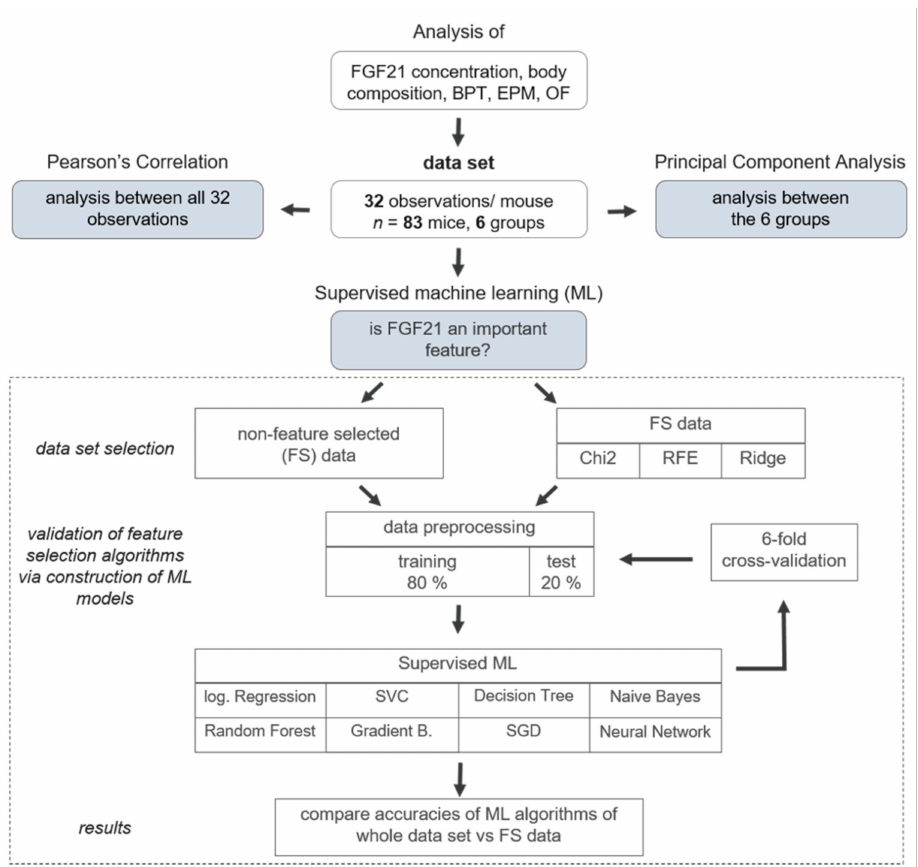
Table S1). To correlate all 32 observations, Pearson’s correlation was performed where linear relationship between two variables is measured. In the heatmap, plotted red colour (1.00–0.70) indicates a strong positive correlation, blue colour ( − 0.70– − 1.00) reveals a strong negative correlation, whereas light colour above 0.40 or under − 0.40 indicates moderate correlation [42]. To reveal the relation between the six intervention groups, Principal Component Analysis (PCA) was conducted. To perform PCA on a dataset where observed entities n were smaller than the observations on variables p ( n < p ), we used a modified PCA implementation in Python with svd_solver = ‘arpack’ [43].